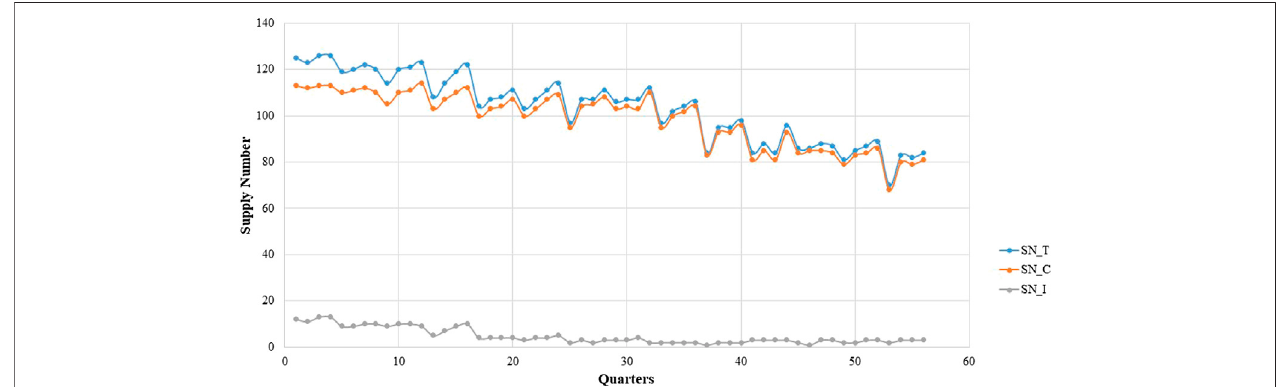
FIGURE 2 | The trend in the quarterly supply number of LPCMs in China from 2005 to 2018.